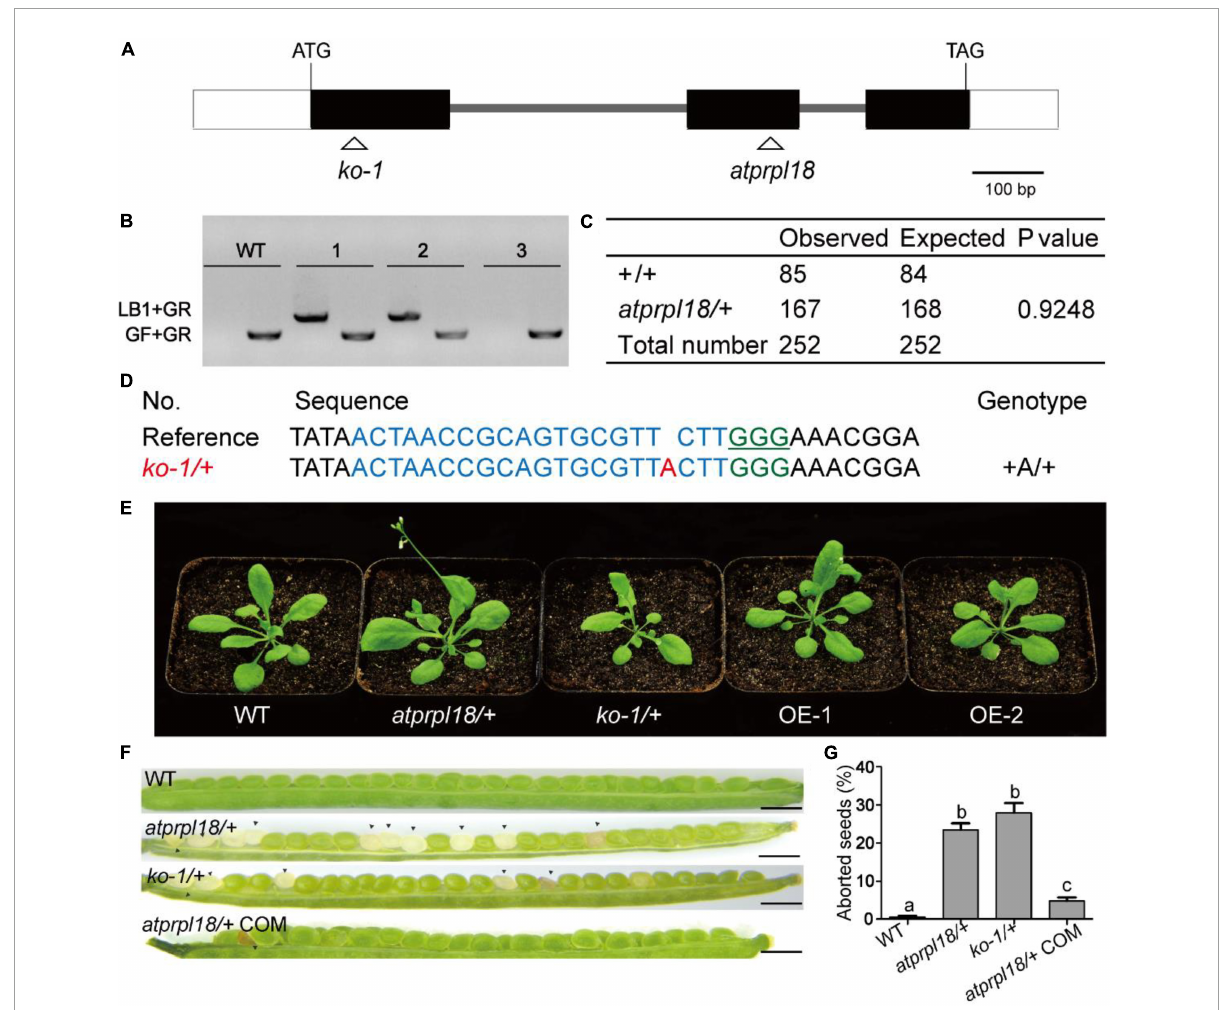
FIGURE3 Characterization of the function of AtPRPL18 in plant development. (A) The gene structure of AtPRPL18 . The gray line, white rectangle, and black rectangle represent intron, 5’/3’UTR, and exon, respectively. (B) PCR analysis of the genotype of the progenies of atprpl18/+ mutant. 1, 2, and 3 were the representative progenies from atprpl18/+ mutant. The T-DNA specific primer LB1 and genomic DNA primer GR were used to amplify T-DNA flanking sequences, GF and GR were used to amplify the genomic DNA sequence without T-DNA insertion. (C) Statistical analysis of the genotypes of atprpl18/+ progenies. (D) Generation of AtPRPL18 deficient mutants by CRISPR-Cas9. The guide RNA targeted DNA sequence and PAM motif were highlighted in blue and green, respectively. (E) 30-day-old plants of atprpl18/+ , ko-1 /+, and AtPRPL18 overexpression transgenic plants OE-1 and OE-2. (F,G) Comparison of the seed phenotypes of WT, atprpl18/+ , ko-1 /+, and atprpl18/+ COM plants. At least fourteen siliques of each genotype were examined. The rates of albino seeds in siliques were analyzed. Data represent means ± SD. Letters above bars indicate significant differences ( P < 0.05, Student–Newman–Keuls test). This experiment was repeated twice with similar results. (a–c) Genetic analysis of the atprpl18/+ mutant.